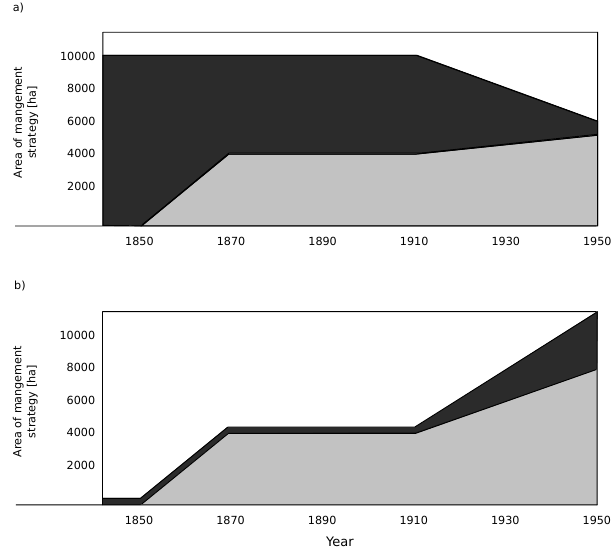
Figure 2. Conceptual presentation of the common forest manage- ment transitions at the pixel level and how these transitions were dealt with in the reconstruction. (a) The amount of coppice area in 1850 was higher than what was required in 1950. (b) The amount of coppice area in 1850 was lower than what was required in 1950. Dark grey shows coppice management; light grey shows high stand